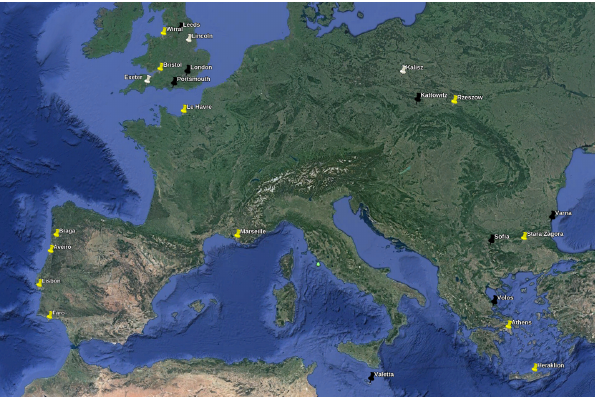
Figure 3: The distribution of the cities which were used for train- ing (yellow), testing (black) and validation (white). pixels between feature points. These feature points were then used as the center point when cutting SAR and optical patches, of 256 × 256 pixels, from the scenes. For training we extracted 50,000 patch pairs from 12 cities; 10,000 patch pairs from 3 cities for validation and 10,000 patch pairs from 8 cities for testing. The distribution of the cities into training, testing and validation sets is depicted in Figure